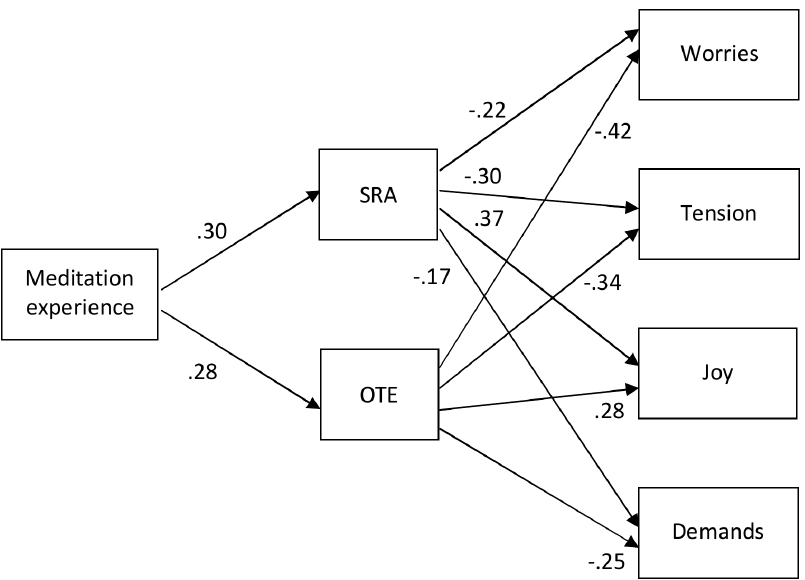
Figure 2. Path model on the effects of meditation experience on mindfulness and on facets of perceived stress in the German data. Numbers are standardized path coefficients. SRA = Self-regulated Attention; OTE = Orientation to Experience. Self-regulated Attention and Orientation to experience were allowed to correlate, as were the facets of perceived stress. All p s # .001.